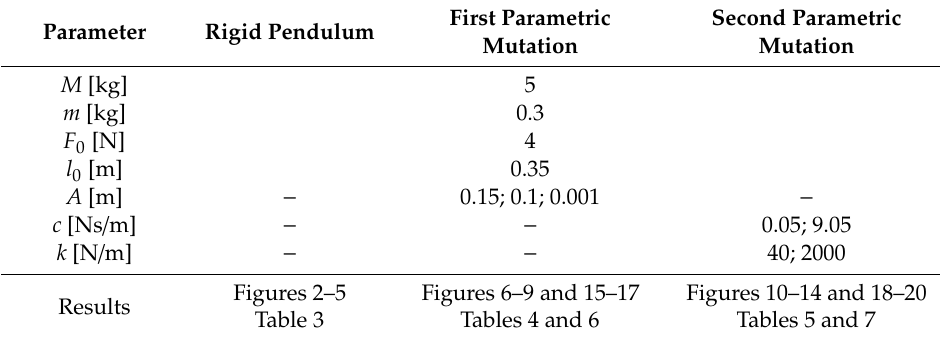
First Parametric Second Parametric Mutation